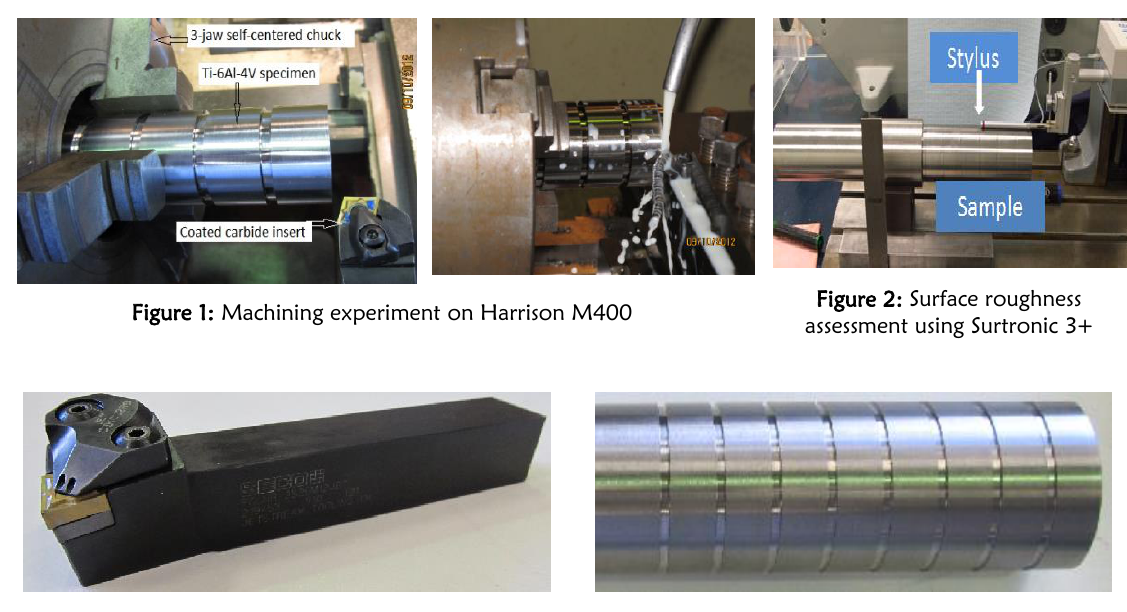
Figure 3: A coated carbide inserts clamped in the tool Figure 4: One half of the Ti-6Al-4V specimen